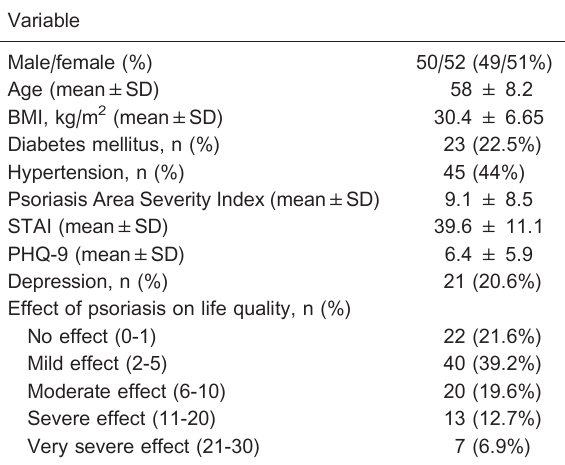
Table 1. Clinical, psychopathological and demographic variables of 102 patients with psoriasis.